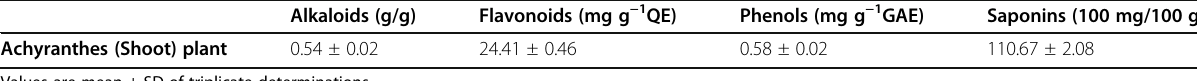
Table 2 Quantitative phytochemical content of aqueous extract of A. aspera shoot